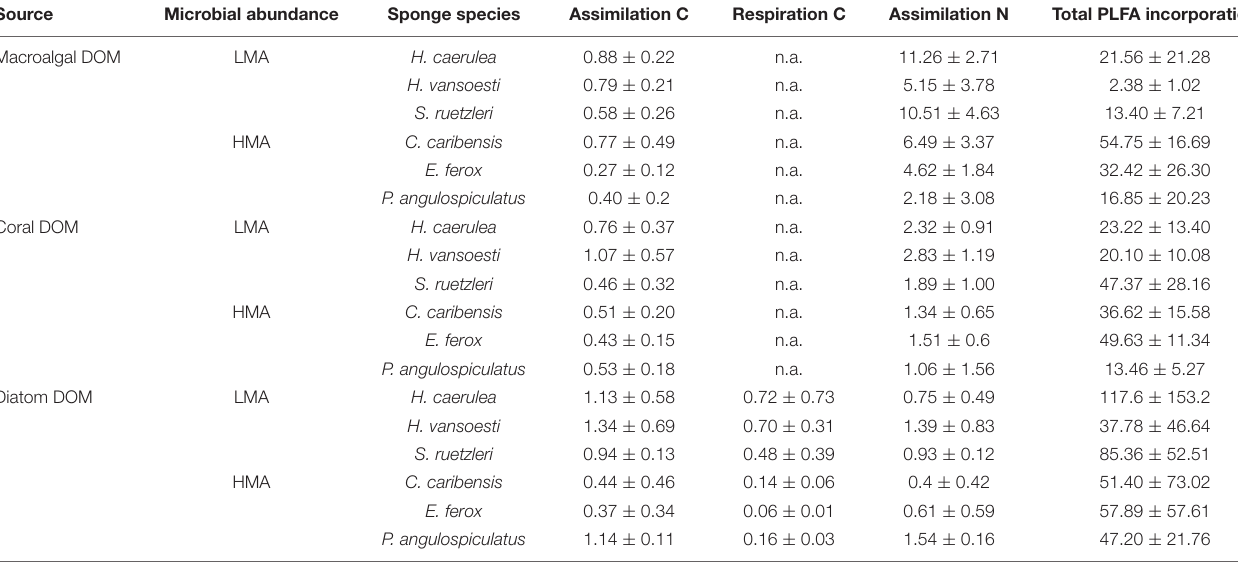
TABLE 2 | Bulk tissue assimilation and respiration rates in µ mol C or N tracer mmol C or N sponge − 1 h − 1 and total PLFA incorporation rates in nmol C tracer mmol C sponge − 1 12 h − 1 of three tracer DOM sources per sponge species.